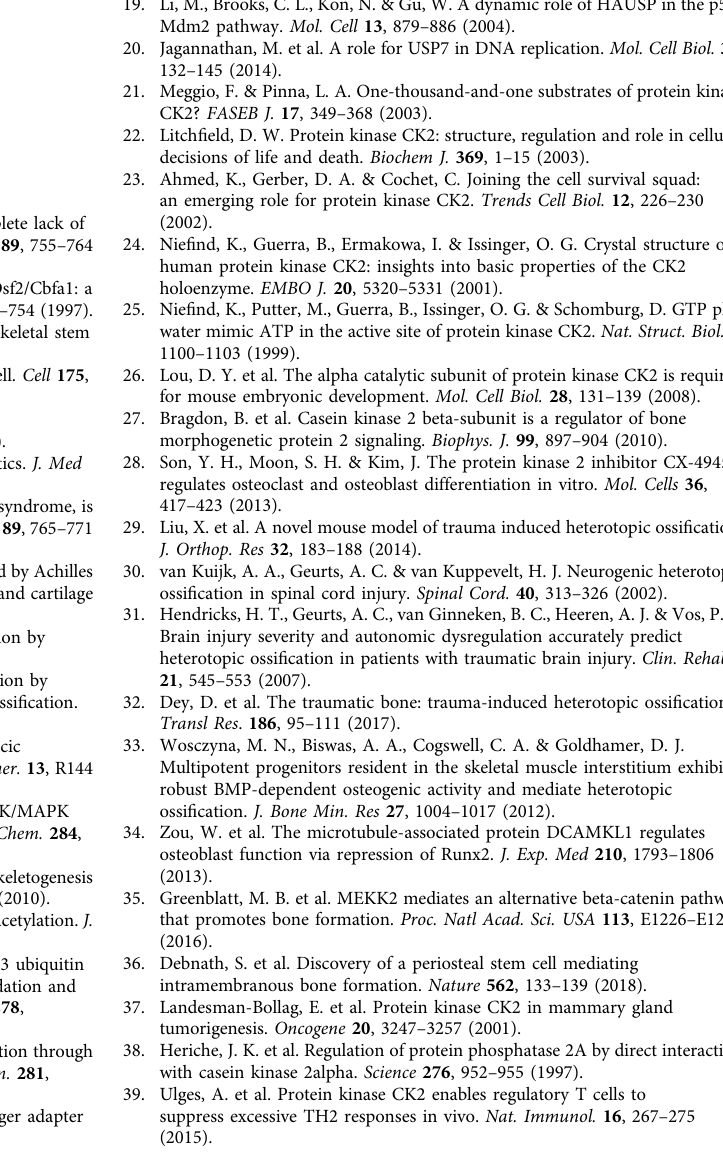
Fig. 7 CK2/HAUSP pathway is required for acquired HO development. a H&E-stained sections (left) and immunohistochemistry (right) for CSNK2A and HAUSP in human HO tissue. Scale bar, 50 μ m. b Achilles tenotomy was performed at 3-month-old male mice. Eight hours after the injury, Achilles tendon was dissected and mRNA levels of Csnk2a1 , and Hausp were measured by RT-PCR. None, non-tenotomized Achilles tendon; HO, tenotomized Achilles tendon. ( n = 4 ( Csnk2a1 ) or 6 ( Hausp )). c – e Quadriceps muscle injury by an aluminum ball drop was performed in 3-month-old Csnk2b fl / fl , Osx-Cre , and Csnk2b Osx male mice, followed by injection of a mixture of rBMP2/7 and matrigel to the injured muscle. HO was assessed by microCT and histology 3 weeks post injury. 3D-reconstruction ( c ) and quanti fi cation ( d ) and H&E-stained sections of HO areas in the muscle ( e ) are displayed. The arrows indicate HO in muscle. B bone, M muscle, C cartilage, BM bone marrow. Scale bars, 1 mm ( c ); 100 μ m ( e ). d n = 7 ( Csnk2b fl / fl ), 7 ( Osx-Cre ) or 4 ( Csnk2b Osx ). f – h Achilles tenotomy was performed in 3-month-old Csnk2b fl / fl , Osx-Cre , and Csnk2b Osx male mice following with a remote burn injury on the back using a heated aluminum block. HO was assessed by microCT and histology 8 weeks post injury. 3D-reconstruction ( f ) and quanti fi cation ( g ) and H&E-stained sections of HO areas in the boxes of the microCT images ( h ) are displayed. None non-tenotomized leg, A Achilles tendon, BM bone marrow, B bone. Scale bars, 1 mm ( f ); 100 μ m ( h ). g n = 11 ( Csnk2b fl / fl ), 7 ( Osx-Cre ) or 6 ( Csnk2b Osx ). i – l 3-month-old wild-type male mice were daily treated with DMSO (Veh) or an inhibitor of CK2 (i-CK2, 2.5 mg/kg) or HAUSP (i-HAUSP, 2 mg/kg) via intraperitoneal (i.p.) injection one day after muscle injury and BMP2/7-matrigel injection ( i , j ) or burn injury and Achilles tenotomy ( k , l ). HO was assessed by microCT analysis 3 weeks ( i , j ) or 8 weeks ( k, l ) post injury. 3D-reconstruction ( i , k ) and quanti fi cation ( j , l ) are displayed. Scale bars, 1 mm ( i , k ). j , n = 7 (DMSO), 7 (i-CK2), or 6 (i-HAUSP); l n = 5 (DMSO), 6 (i-CK2) or 7 (i-HAUSP). Data are representative of three ( a – c , e , f , h , i , k ) independent experiments or are pooled from two experiments ( d , g , j , l ). A two- tailed unpaired Student ’ s t test for comparing two groups ( b , d , g ) and ordinary one-way ANOVA with Dunnett ’ s multiple comparisons test ( j , l ; error bars, SD of biological